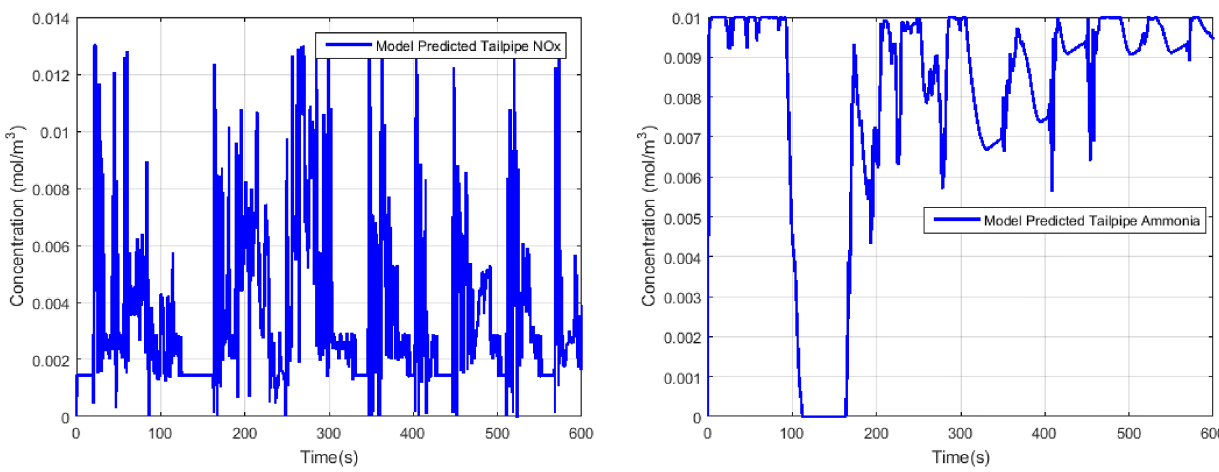
Fig 5. The model predicted tailpipe NOx and ammonia concentration.